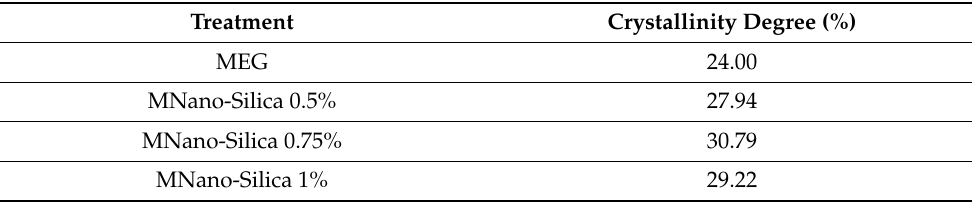
Table 4. Crystallinity degree of treated sengon wood.